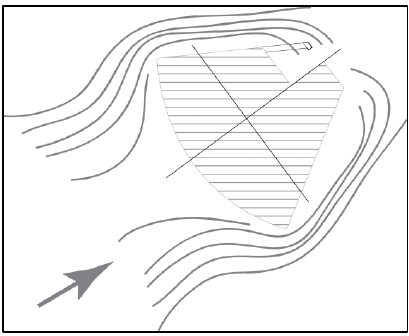
Figure 25. Circulation - aerodynamic form of the optimized base of the dwelling in Lepenski Vir The losses in the transfer of heat energy are reduced by the compactness of the shell, by drying up the walls and by improving the thermal insulation properties of materials used for walls using solar radiation, which is the reason why the most favourable orientation to the east and river is